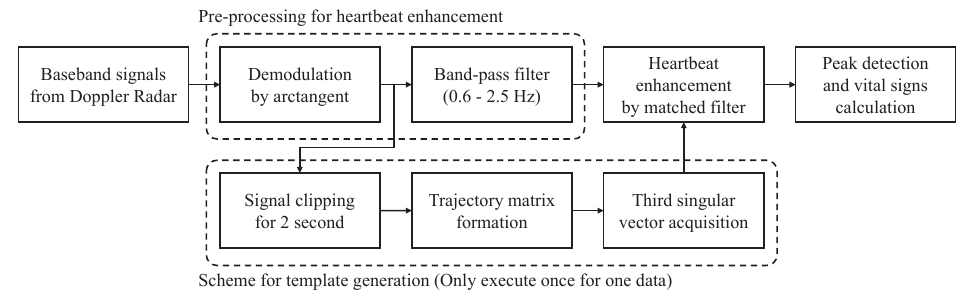
Figure 2. The diagram showing the proposed method for extracting cardiac